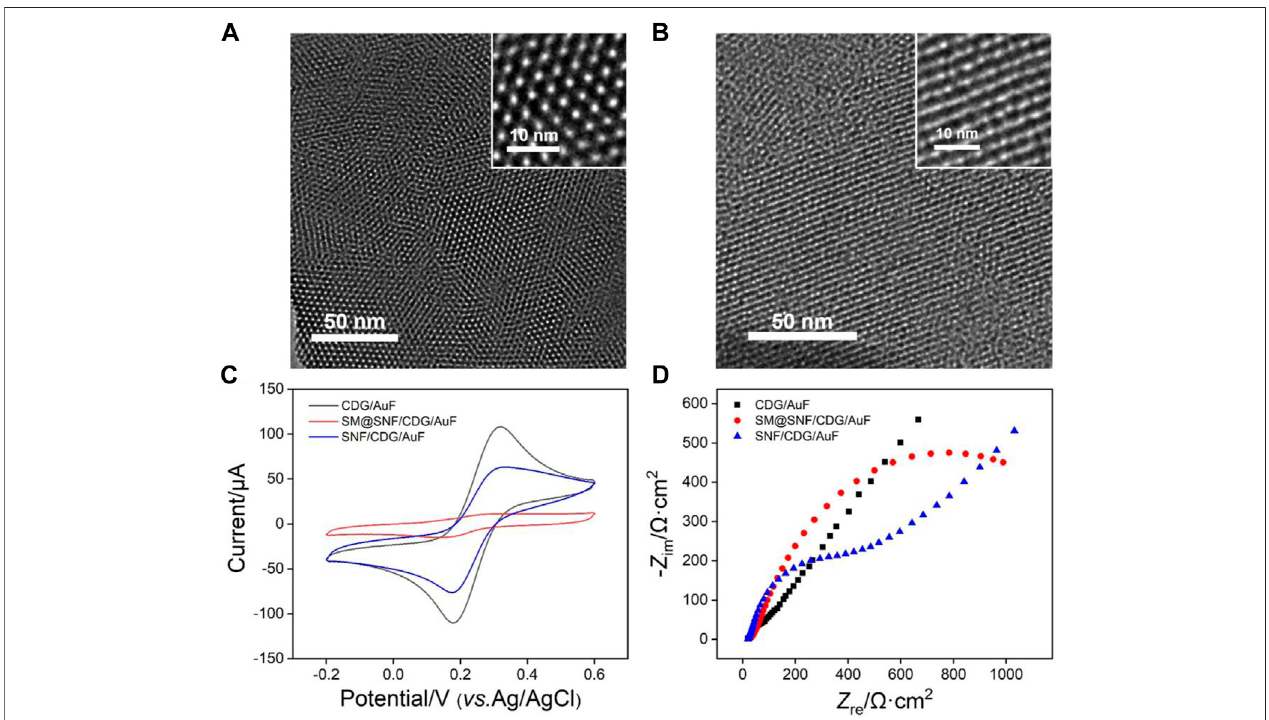
FIGURE 3 | Top-view (A) and cross-sectional (B) TEM images of SNF. The insets show TEM images at high magni fi cation. (C) CV curves obtained at different electrodes in 0.05 M KHP solution containing 0.5 mM Fe(CN) 63+ . The scan rate was 100 mV/s. (D) Nyquist plots of different electrode obtained in 0.1 M KCl solution containing 2.5 mM K 3 Fe(CN) 6 and 2.5 mM K 4 Fe(CN) 6